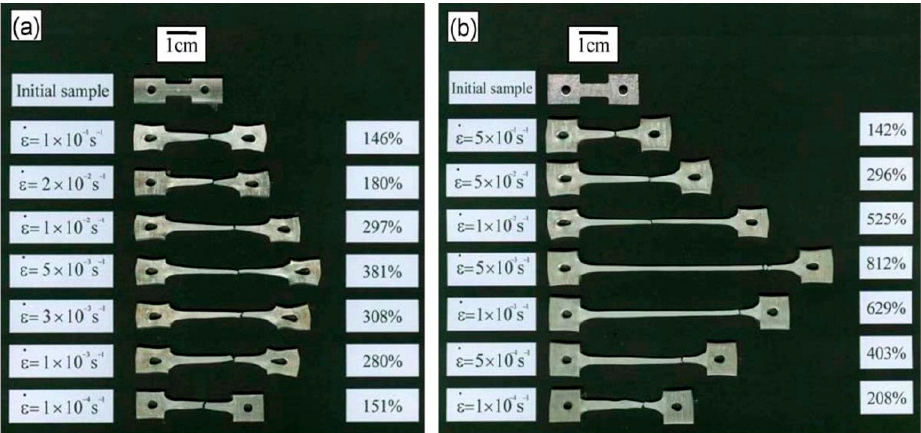
Figure 8. ( a ) Equal channel angular pressing (ECAP)-processed sample, ( b ) ECAP + post rolled samples, reproduced from [95], with permission from Elsevier, 2005.